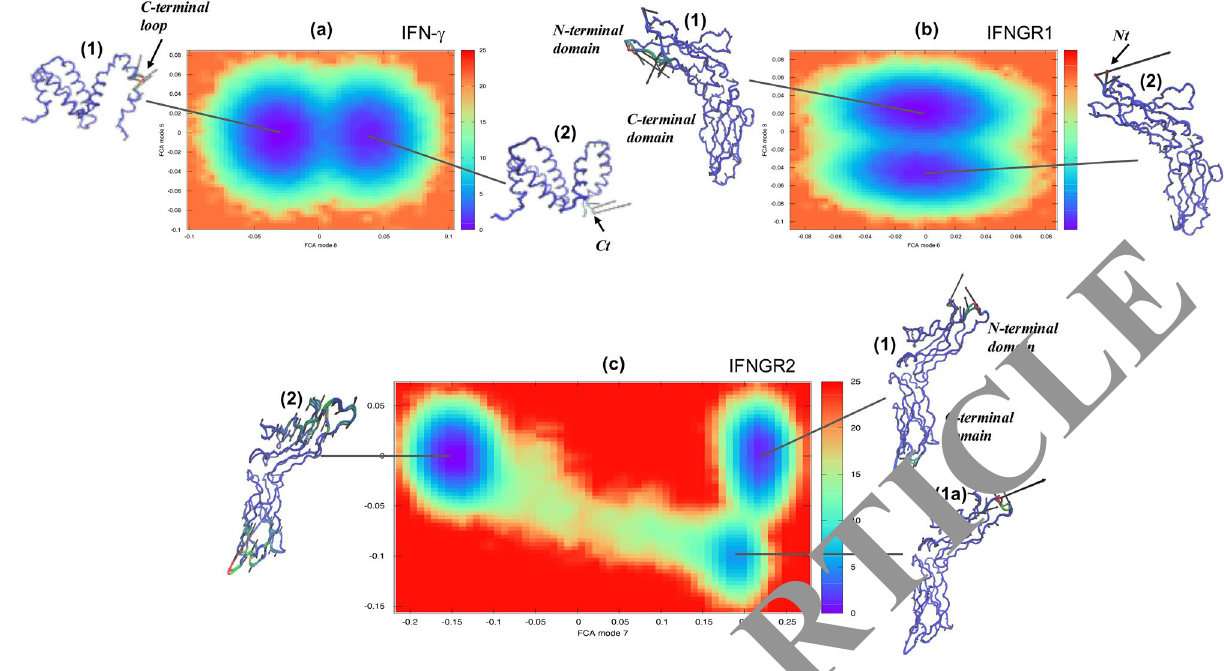
Figure 10. Free energy surface derived from the FCA of the MD trajectory of ( a ) IFN-γ, ( b ) IFNGR1, and ( c ) IFNGR2 from the IFN-γ receptor complex in a mixed water–ethanol solvent. The C-a representation of each conformation illustrates the dominant motion within the minimum of the energy surfaces where regions colored in red show greater mobility and regions in blue have less